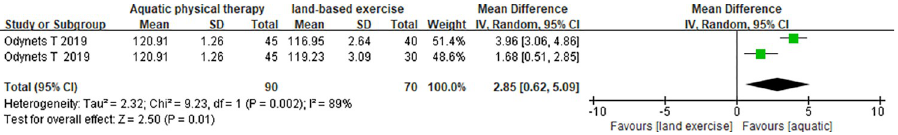
Fig 6. Meta-analysis of studies assessing QoL between aquatic physical therapy and land-based